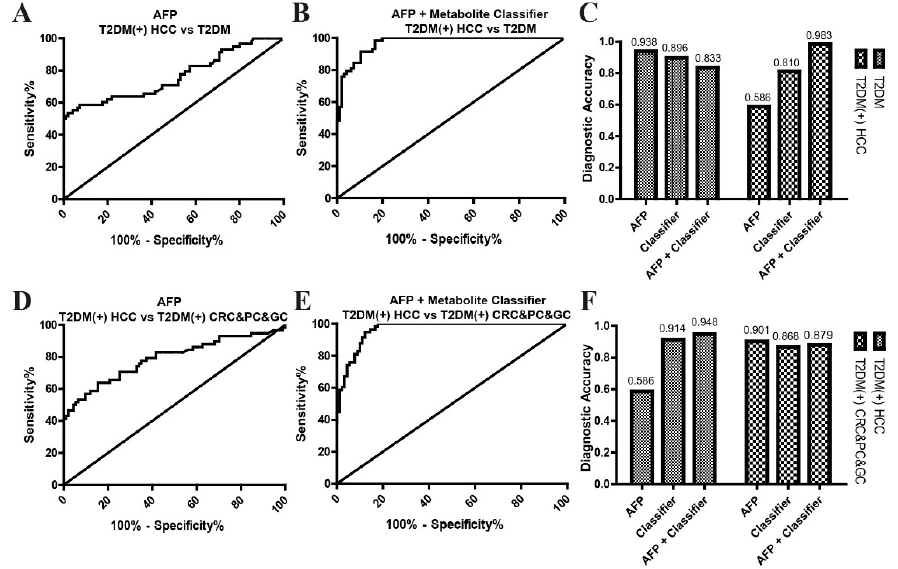
Figure 9. The combination of AFP and the metabolite classifier for T2DM(+) HCC diagnosis. ( A ) ROC curve of AFP for discriminating T2DM(+) HCC patients from T2DM patients. ( B ) ROC curve of the combination of AFP and the metabolite classifier for discriminating T2DM(+) HCC patients from T2DM patients. ( C ) The corresponding diagnostic accuracy for the diagnosis of T2DM and T2DM(+) HCC patients. ( D ) ROC curve of AFP for discriminating T2DM(+) HCC patients from T2DM(+) CRC&PC&GC patients. ( E ) ROC curve of the combination of AFP and the metabolite classifier for discriminating T2DM(+) HCC patients from T2DM(+) CRC&PC&GC patients. ( F ) The corresponding diagnostic accuracy for the diagnosis of T2DM(+) HCC and T2DM(+) CRC&PC&GC individuals.